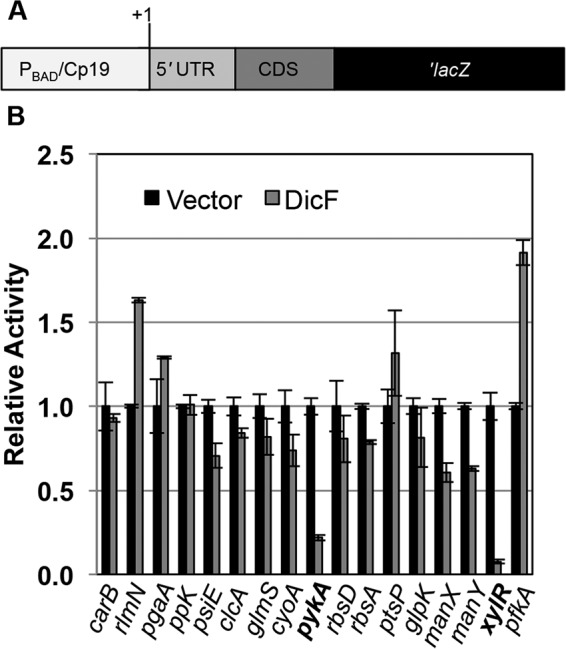
The genes pykA and xylR are posttranscriptionally regulated by DicF. (A) A schematic of reporter fusion constructs used in this experiment. Selected candidates from Table 1 were fused to ′lacZ and integrated as single copies on the E. coli chromosome, under the control of either an arabinose-inducible (PBAD) promoter or a constitutive (Cp19) promoter (see text), followed by the 5′ untranslated region (5′ UTR) of the gene and 10 to 20 amino acids of the coding sequence. (B) The fusions created in a wt E. coli host strain were assayed for β-galactosidase activity after DicF expression from a plasmid. The specific activities (quantified in Miller units) were normalized to the vector control of the corresponding strain to yield relative-activity data. The targets chosen for further study (indicated in bold) were up- or downregulated by DicF at least 2-fold.